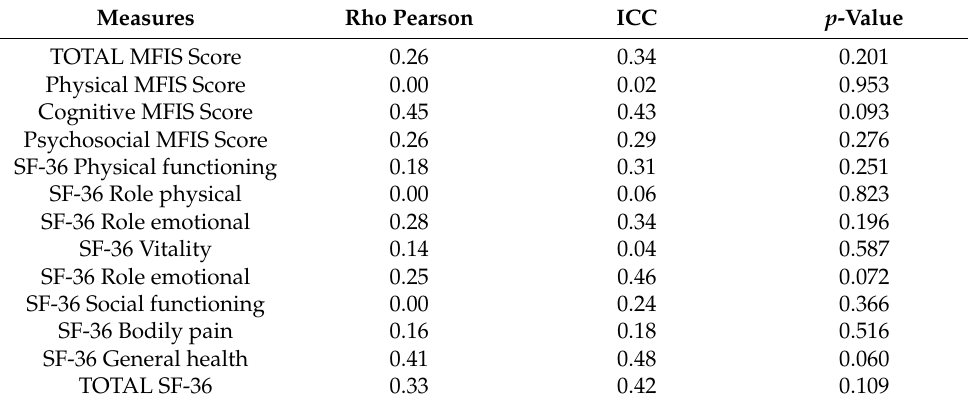
Table 2. Construct validity of RUNZI ® app with MFIS and the SF-36.